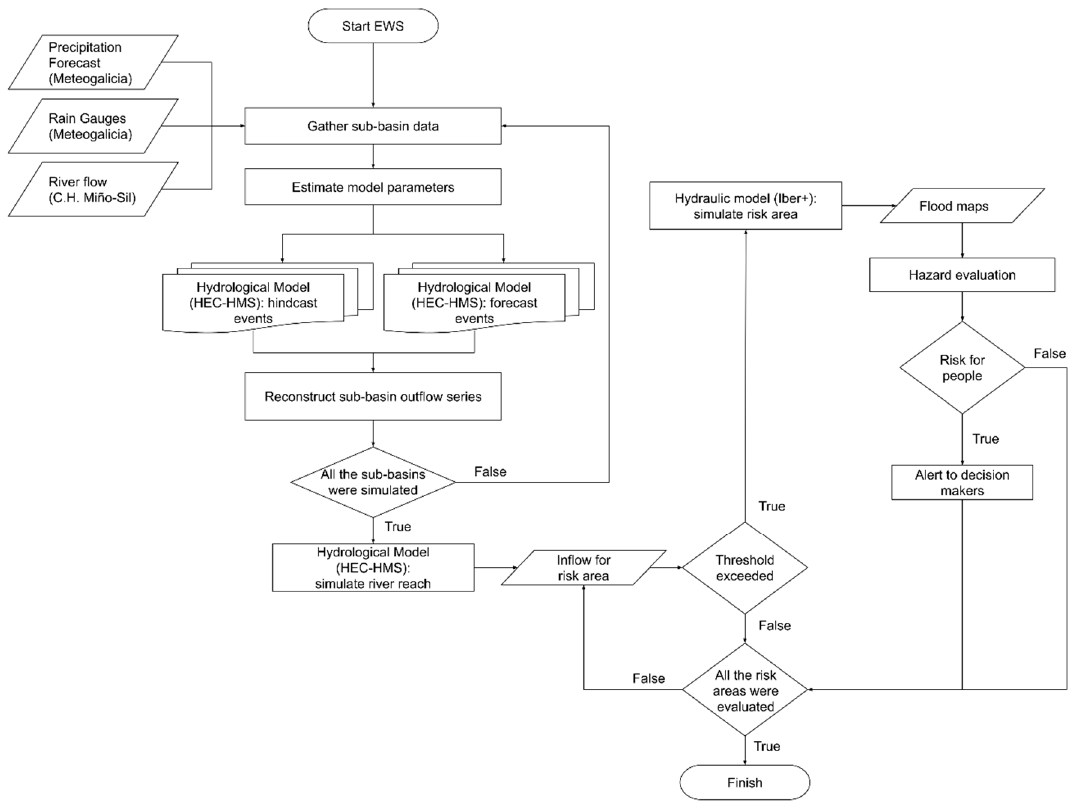
Figure 2. Flowchart of the Miño River Flood Alert System (MIDAS) early warning system.